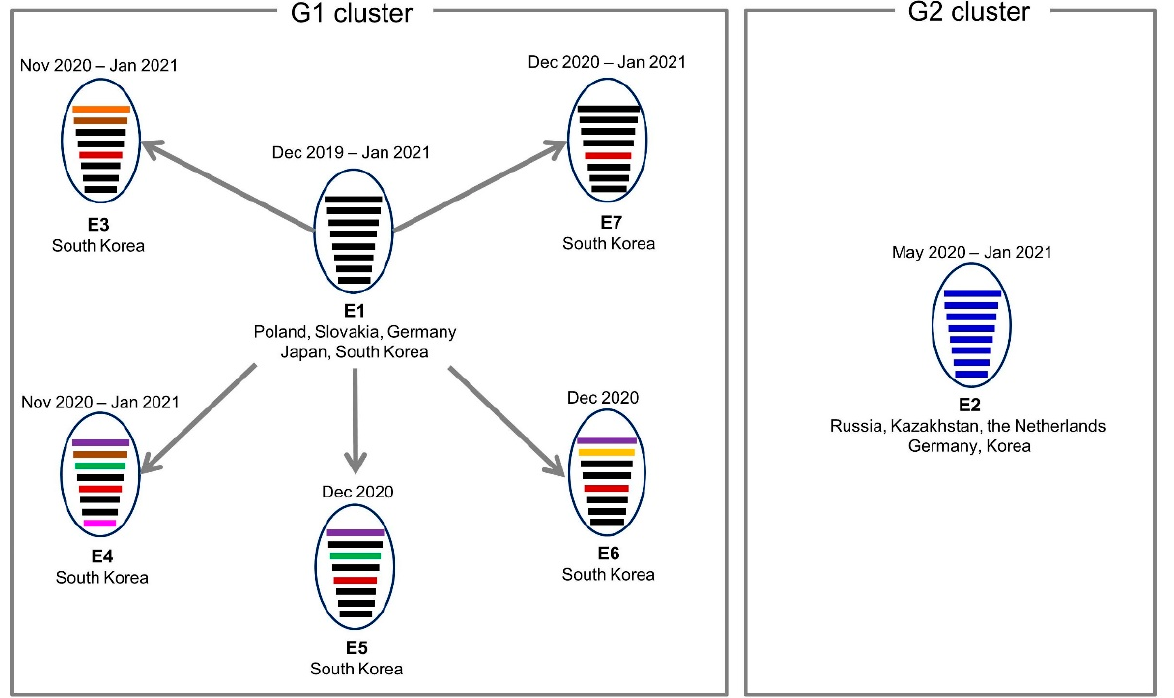
Figure 3. Genome constellation of clade 2.3.4.4b H5N8 highly pathogenic avian influenza (HPAI) viruses in South Korea during the winter of 2020–2021. Oval lines represent the avian virus, and horizontal bars indicate the eight gene segments (from top to bottom): polymerase basic protein 2, polymerase basic protein 1, polymerase acidic protein, hemagglutinin, nucleoprotein, neuraminidase, matrix protein, and non-structural protein. Each color represents a different viral origin: black, late 2019–early 2020 Europe H5N8 HPAI virus [17,18]; blue, late 2020 H5N8 Europe HPAI virus [19]; green, red, purple, orange, dark orange, and cyan blue, Eurasian low pathogenic avian influenza viruses. Host transition analysis of the H5N8 clade 2.3.4.4b HPAI viruses during the winter of 2020–2021 was performed by estimating the transition rate, Markov jump count, BF,